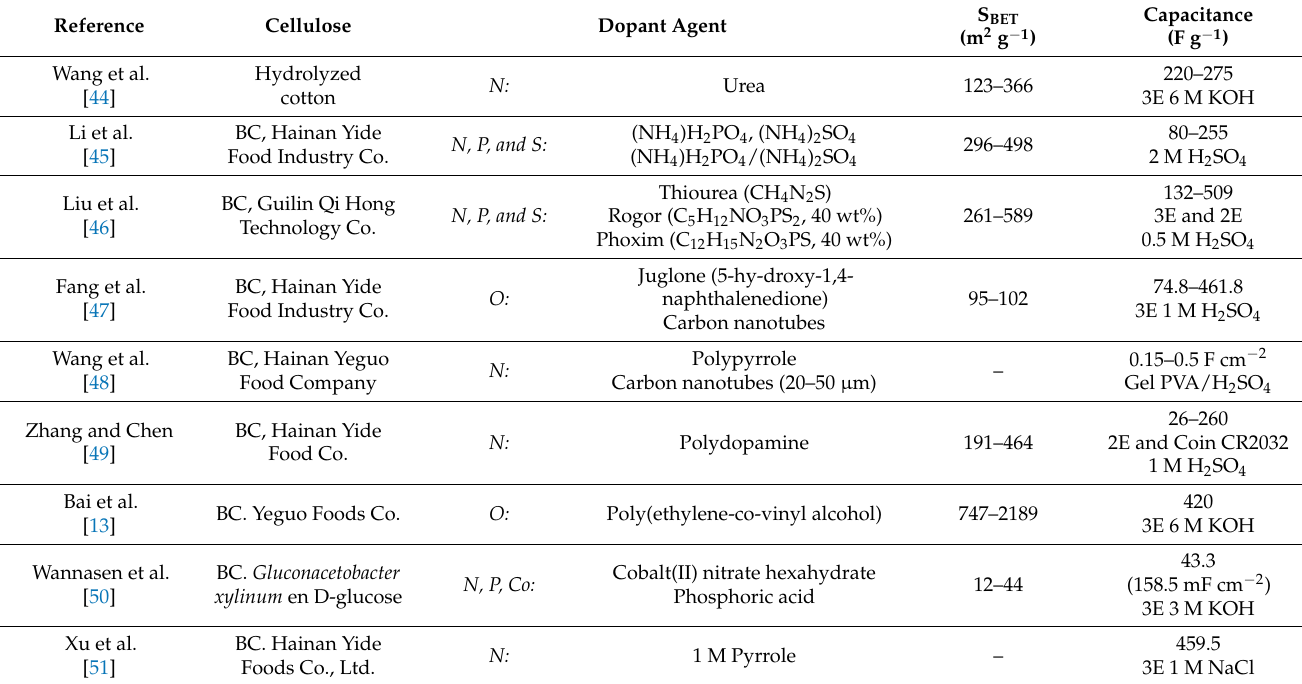
Table 4. Gravimetric capacities of electrodes from doped BNCs. 3E: three-electrodes configuration; 2E: two-electrodes configuration.